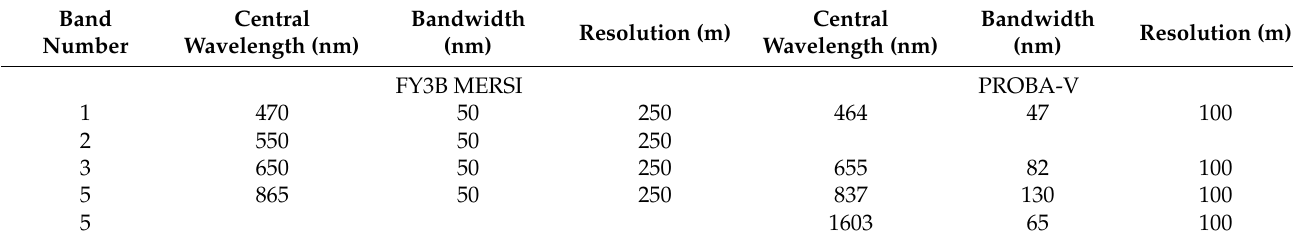
Table 6. The band specification and spatial resolution of PROBA-V and FY3B